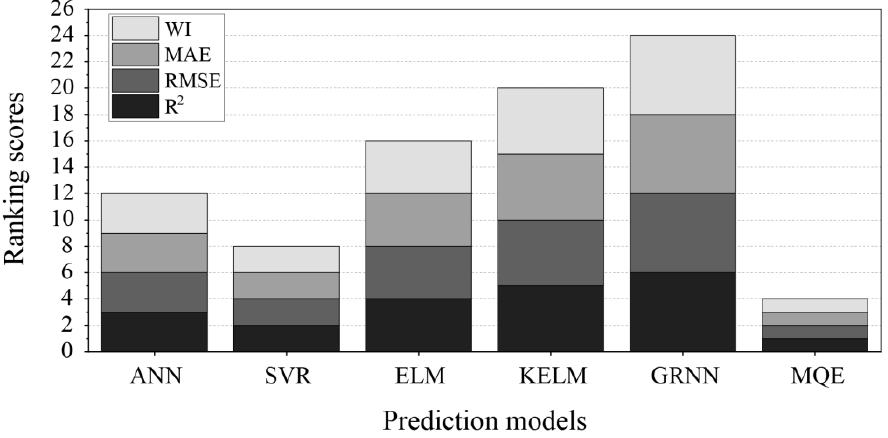
Figure 9. Ranking scores of the six comparison models using the test set.